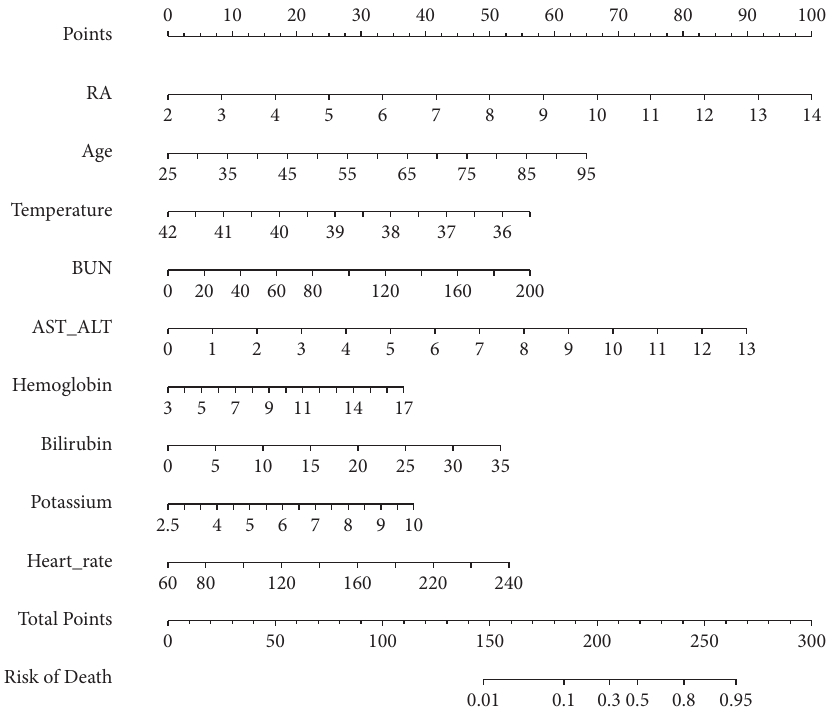
Figure 2: Nomogram predicting 30-day mortality in patients with acute pancreatitis. To use a nomogram, draw a vertical line from each variable up to the point. Te resulting value is the patient’s score on that variable (i.e., “RA � 8” � 50 points). Te scores for each variable were then summarized to obtain a total score corresponding to the 30-day probability of death predicted at the bottom of the nomogram. We then plotted a vertical line from the axis of the total point down to the 30-day survival probability, thus obtaining the 30-day survival probability for this patient. RA, red blood cell distribution width-albumin ratio; BUN, blood urea nitrogen.